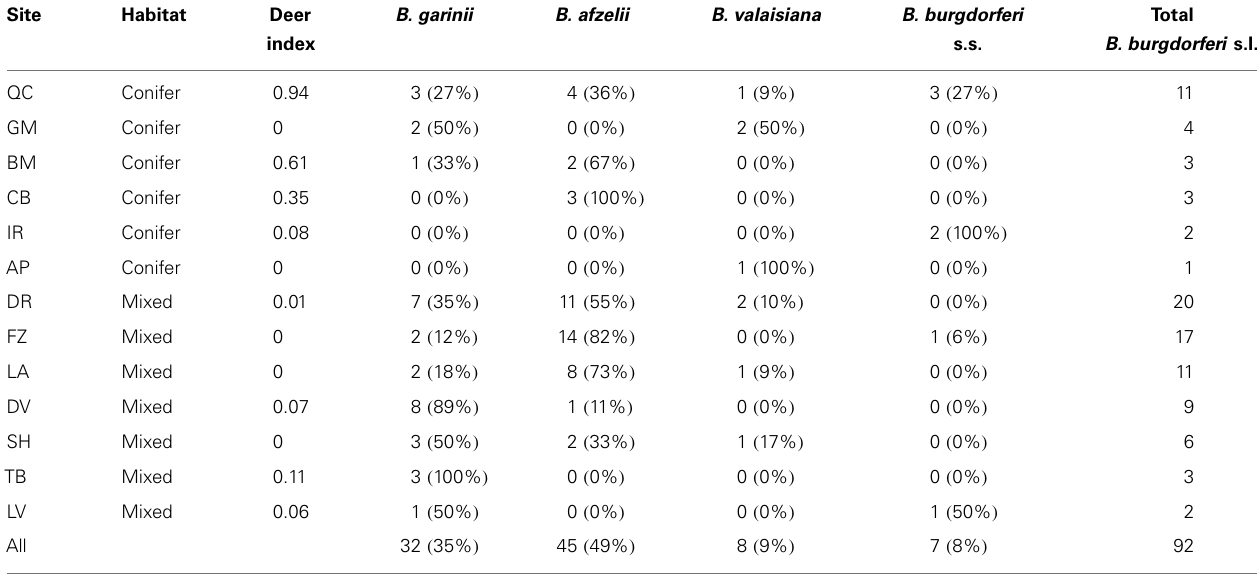
Table 2 | Genospecies of B. Burgdorferi s.l. and sample size of positive samples from questing nymphs at each site . Site